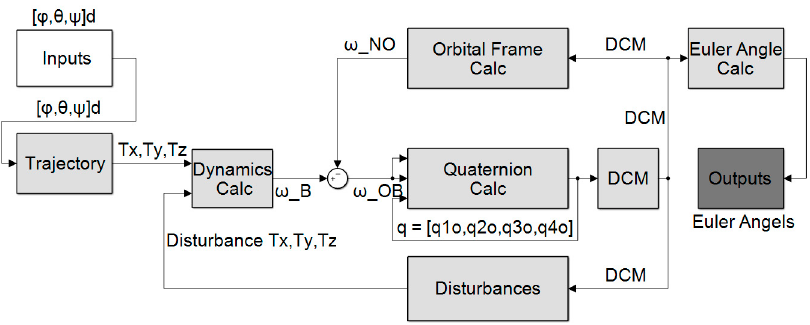
Figure 1. Overall technical roadmap of the overall process: Euler Angle for Euler’s Moment Equation driven by a trajectory-fed feedforward controller.